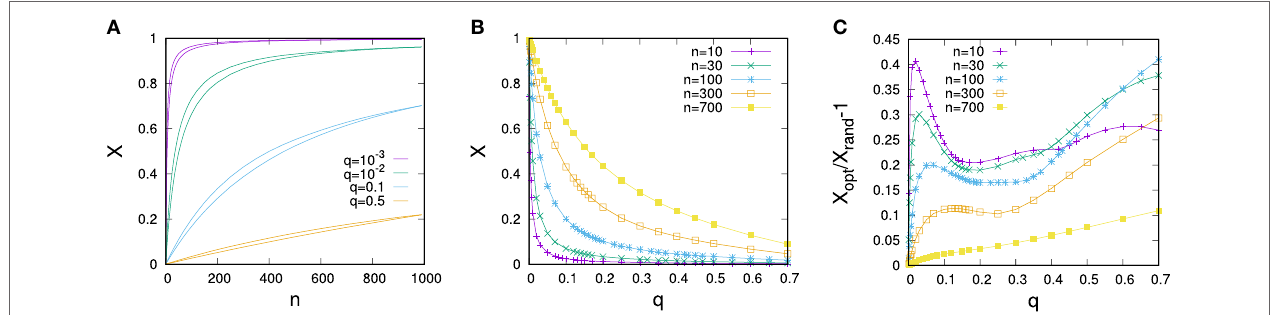
FIGURE 1 | (A) Dependence of the controlled share of votes X on the resource of the controller n . For each color, the lower curve gives the vote share for random allocation of control and the upper curve vote shares for optimized allocations. (B) Dependence of optimized vote shares on the predisposition parameter q for various control resource endowments n . (C) Optimization gain relative to random control allocation for the scenario shown in (B) . The data are for networks composed of N = 1,000 nodes constructed for (cid:11) = 3 and each data point represents an average over 50 randomly sampled network configurations. Error bars are of the size of the lines/points.